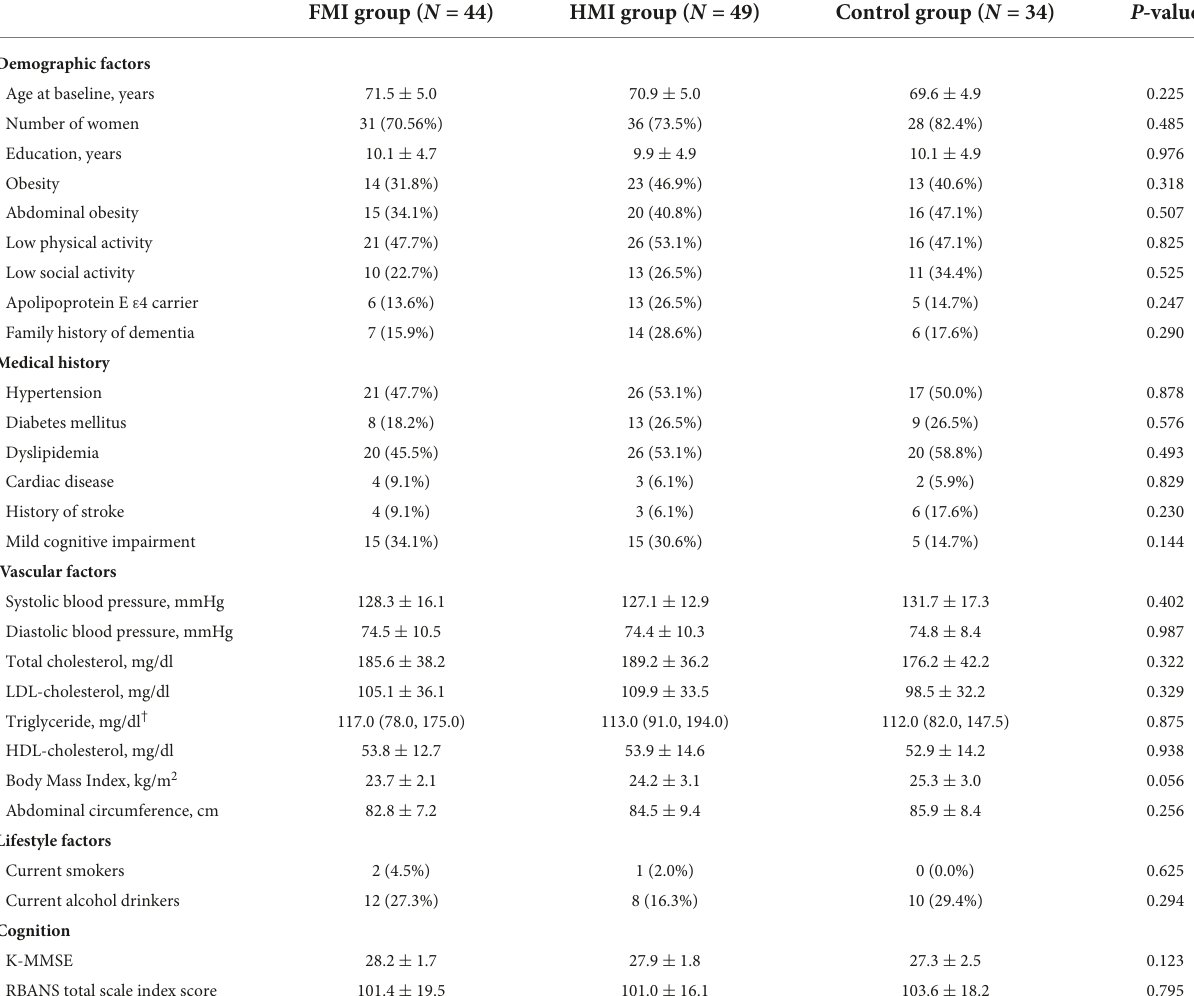
TABLE 1 Clinical characteristics of all participants in this